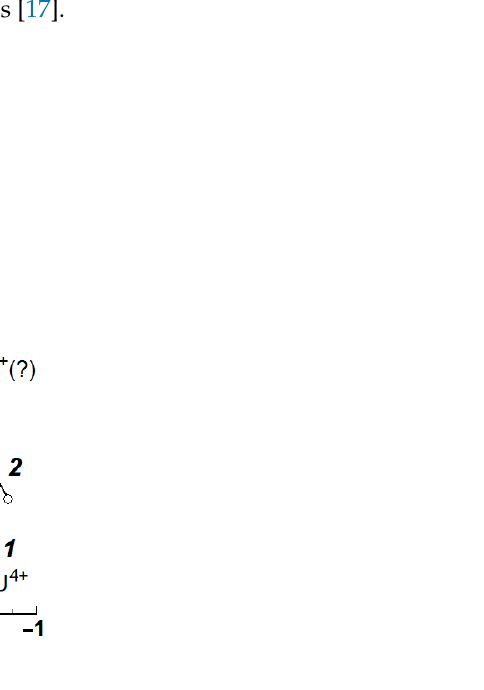
Figure 4. Cathodic polarization curves of tungsten electrode in 3LiCl–2KCl eutectic based melts containing 1.65 wt. % UCl 3 at 546 °C (1) or 5.47 wt. % ZrCl 4 at 532 °C (2). Potentials vs. 2Cl – /Cl 2 reference couple.